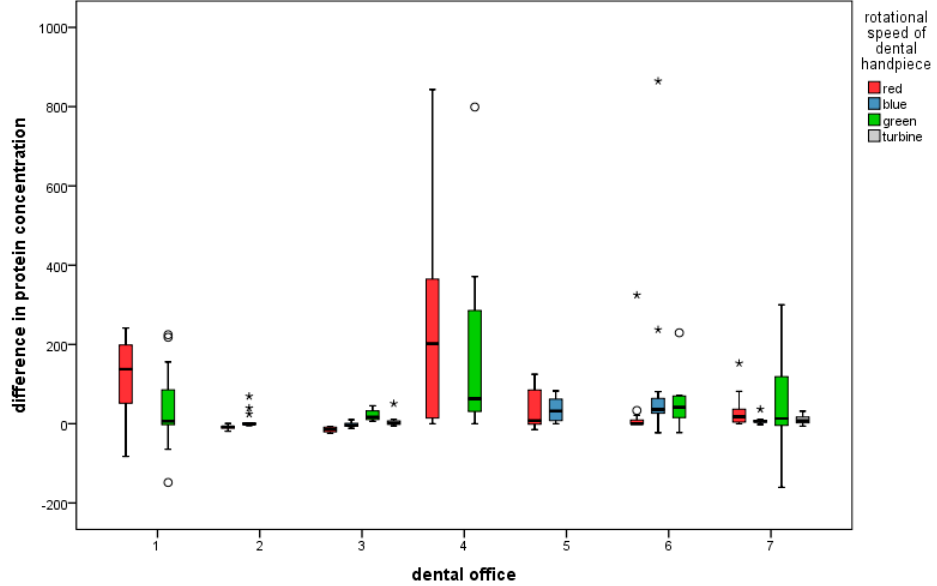
Figure 4. Correlation of the investigated office with the type of treatment (* and ◦ for outliers).